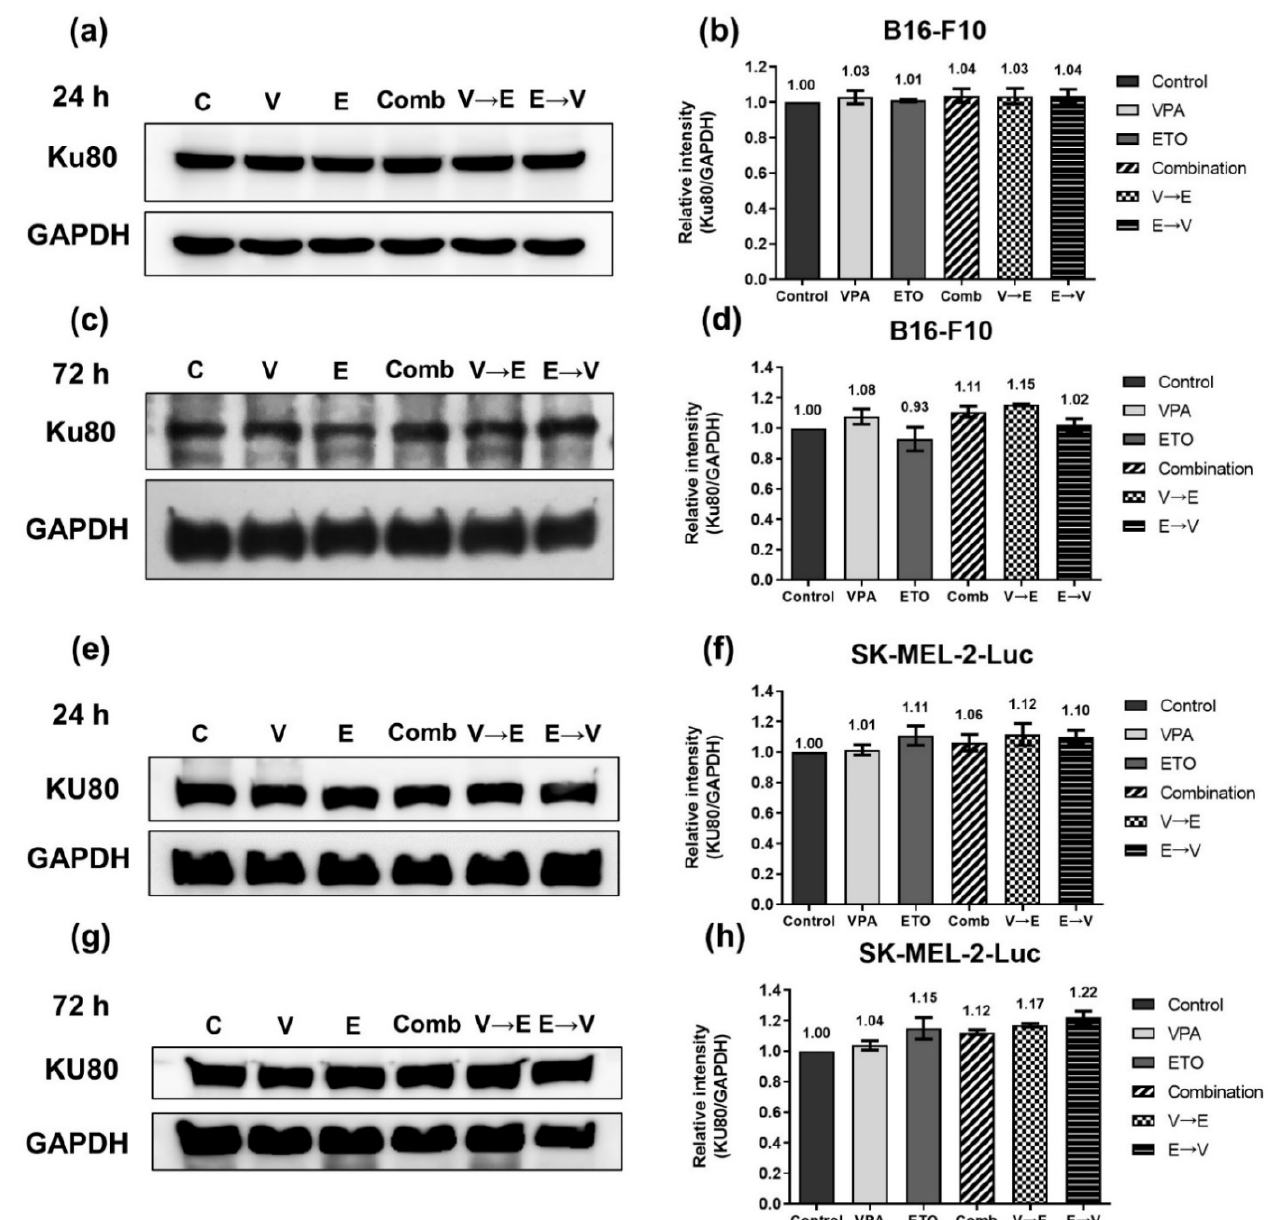
Figure 9. Expression of non-homologous end joining (NHEJ) related protein Ku80/KU80, under single, simultaneous, and sequential combined treatments of VPA and ETO in melanoma cells. Western blot analysis illustrated the Ku80/KU80 protein expression after ( a ) 24 h ( c ) 72 h single, simultaneous, and sequential combined treatments of VPA and ETO in B16-F10 cells. ( b , d ) was quantitative analysis of ( a , c ), respectively, which was obtained by using Image J software 1.52a (National Institutes of Health, Bethesda, MD, USA). The analysis was repeated in SK-MEL-2-Luc cells. Western blot data of ( e ) 24 h and ( g ) 72 h was shown, and the corresponding quantitative analysis was shown in ( f , h ), respectively. GAPDH was used as the control of sample loading. Relative intensities of Ku80/KU80 to GAPDH expressions were normalized with the control. The data are shown as means ± SEM of independent experiments in triplicate. The drug dosages were referred to IC 50 values as shown in Figure 2 and Table